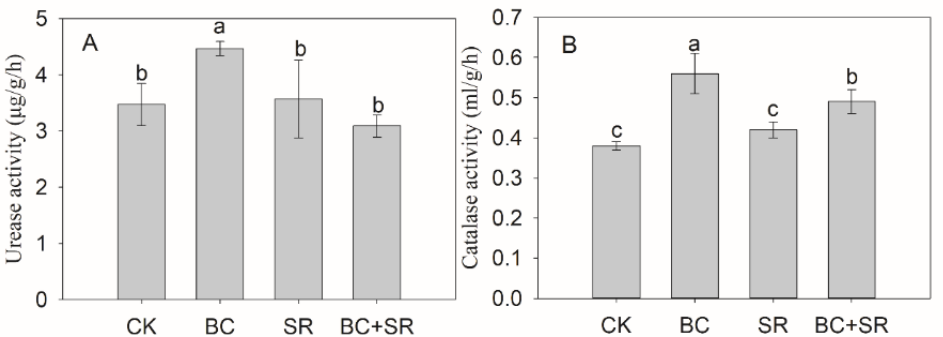
Figure 7. Effect of different soil types on soil urease activity ( A ) and catalase activity ( B ). CK, sand only; BC, biochar; SR, sand and soft rock; BC + SR, sand, biochar, and soft rock. Data are shown in mean ± SD. Different letters indicate significant differences ( p < 0.05).